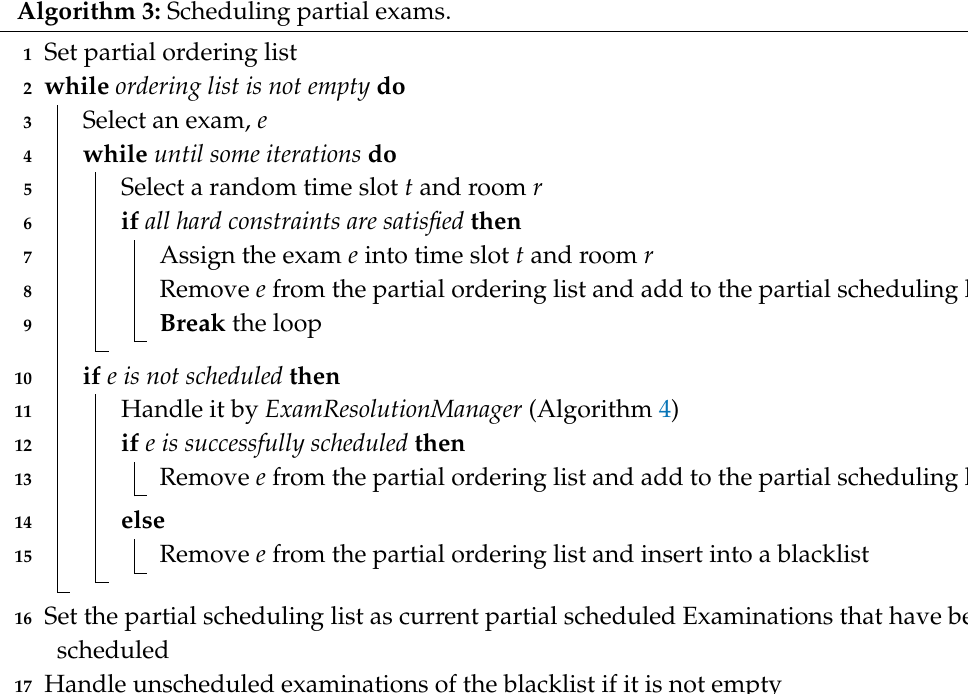
Algorithm 3: Scheduling partial